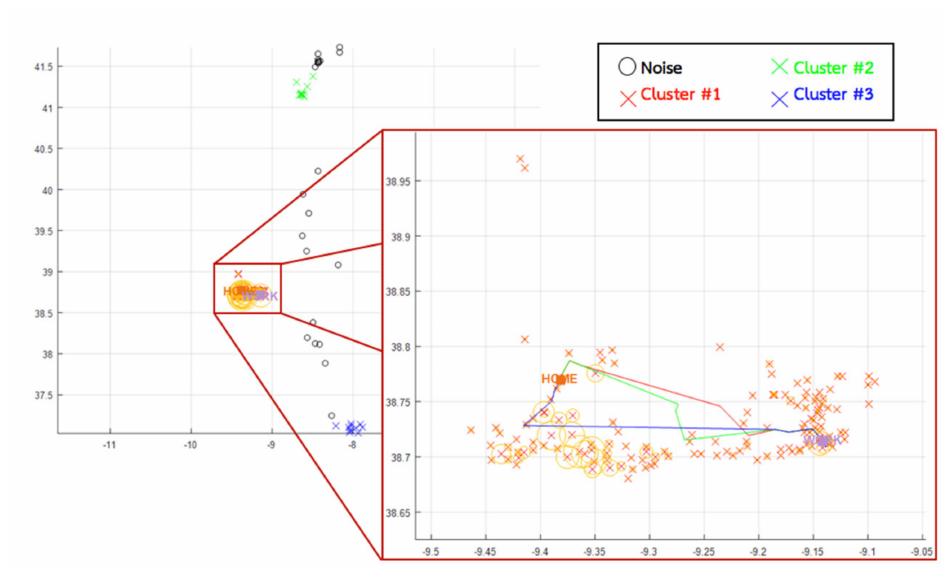
Figure 14. Clustering result of DBSCAN from which its Cluster #1 is further considered for the route choice inference while the rest of the visited cell towers are considered as a noise and discarded.